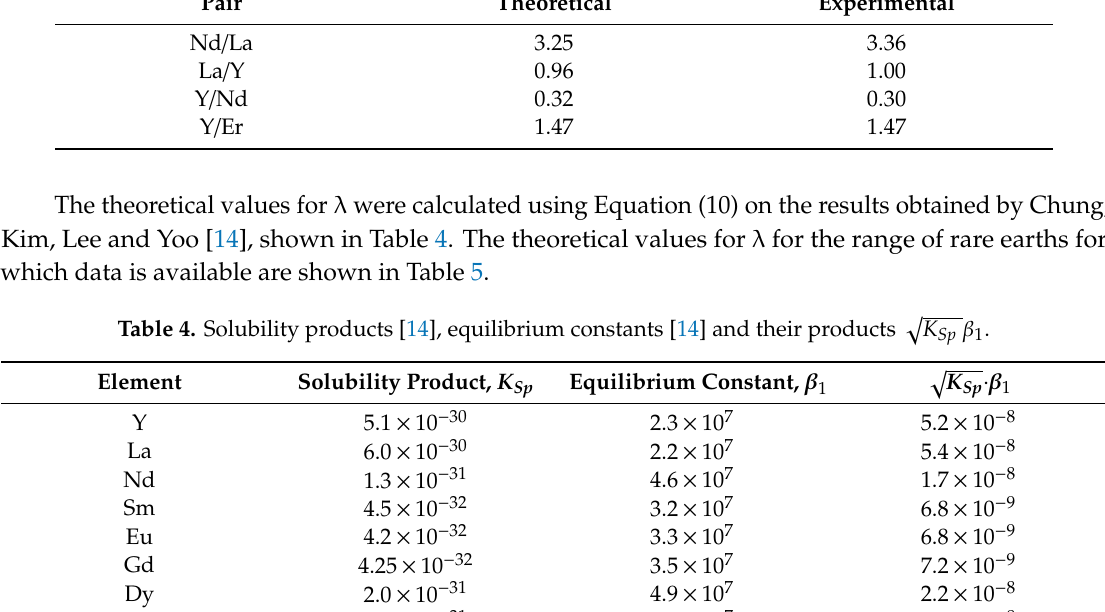
Table 3. Comparison between theoretical and experimentally obtained values for the logarithmic distribution coe ffi cient.